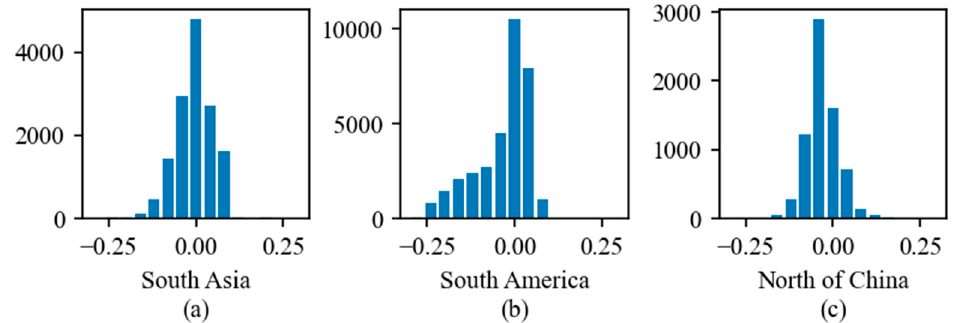
Figure 12. Difference histogram between our results and the OMAERUV product; ( a ) South Asia on 25 June 2019, ( b ) South America on 19 September 2019, ( c ) North China Plain on 1 January 2019.